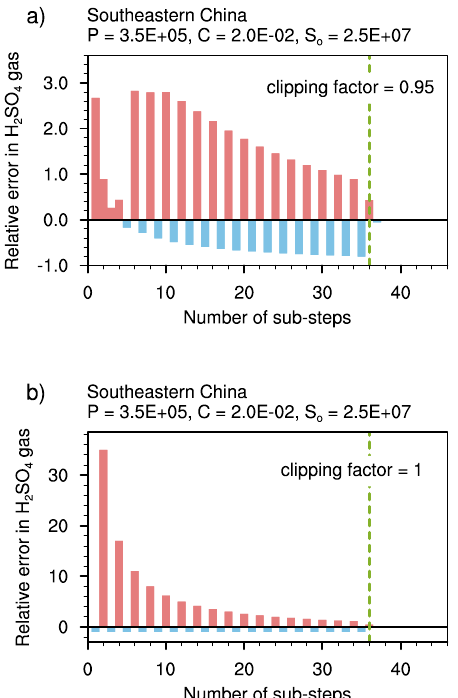
Fig. 6. Relative errors of H 2 SO 4 gas concentration in box model calculations that solve the production-condensation equation using the Euler forward scheme for an 1 h integration time. Typical val- ues of the production rate P , condensation coefficient C , and initial value S 0 in Southeast China are used, which represents region asso- ciated with persistent positive errors in Fig. 5b–e. The dashed green line indicate the stability threshold 1t = 2 /C (cf., e.g., Chapter 2 in Butcher, 2008). In panel (a) the estimated condensation rate at each step of time integration is limited to 95% of the total available H 2 SO 4 gas, while in panel (b) this clipping factor is set to 1. Note that the two panels use different scales for the y-axis. Further details can be found in Sect.